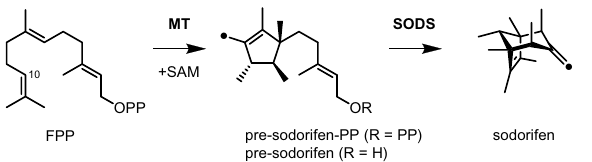
Figure 1. Biosynthesis of sodorifen from FPP catalyzed by a C -methyltransferase (MT) to afford cyclic PSPP as a non-canonical substrate for the terpene synthase (SODS). The black dot on pre-sodorifen and sodorifen indicate the methyl group transferred from